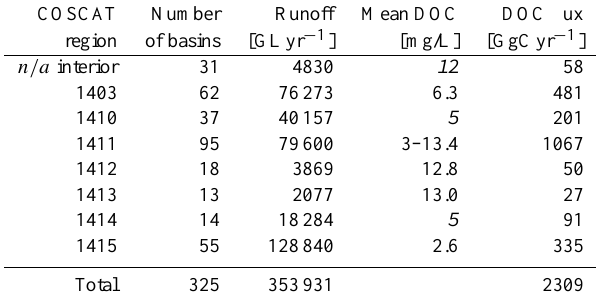
Table 4. Mean annual runoff (Raupach et al., 2009) draining into Australian COSCAT regions (Fig. 13), mean DOC concentrations computed from observed concentration data (italics denote assumed DOC concentration used to compute DOC fluxes), and DOC fluxes computed using each of the three runoff estimates. Fluxes were cal- culated using the maximum concentration observed in region